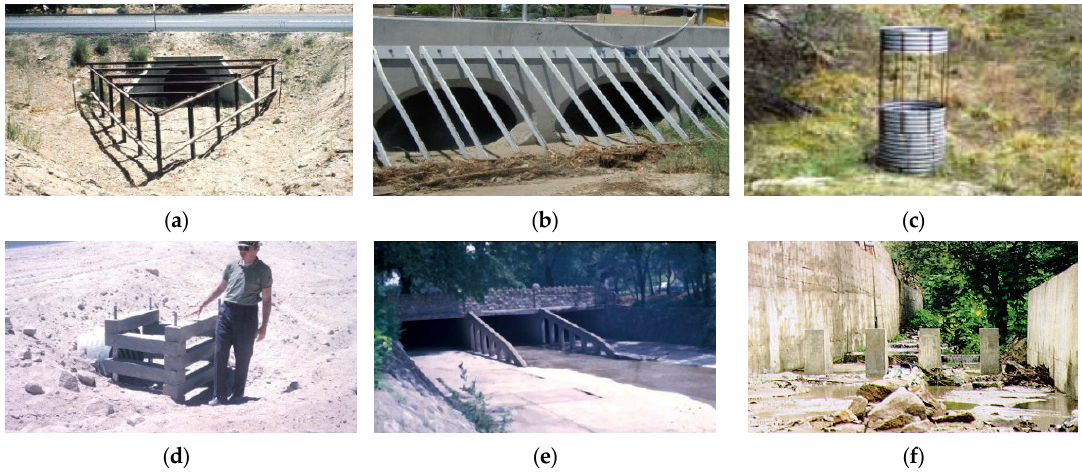
Figure 1. Debris control structures: ( a ) deflector; ( b ) rack; ( c ) riser; ( d ) crib; ( e ) fin; ( f ) dam [35].